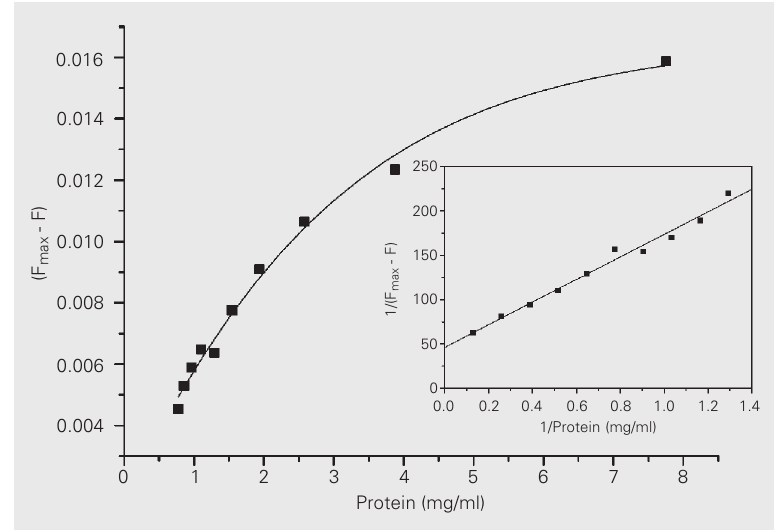
Figure 4. Analysis of the titration of dipyridamole (DIP) with HEp-2 cell membrane by fluorescence for the calculation of the association constant. Inset: Double reciprocal plot of the change in DIP fluorescence emission vs 1/protein. DIP concentration of 1 µM, excita- tion at 415 nm and emission at 495